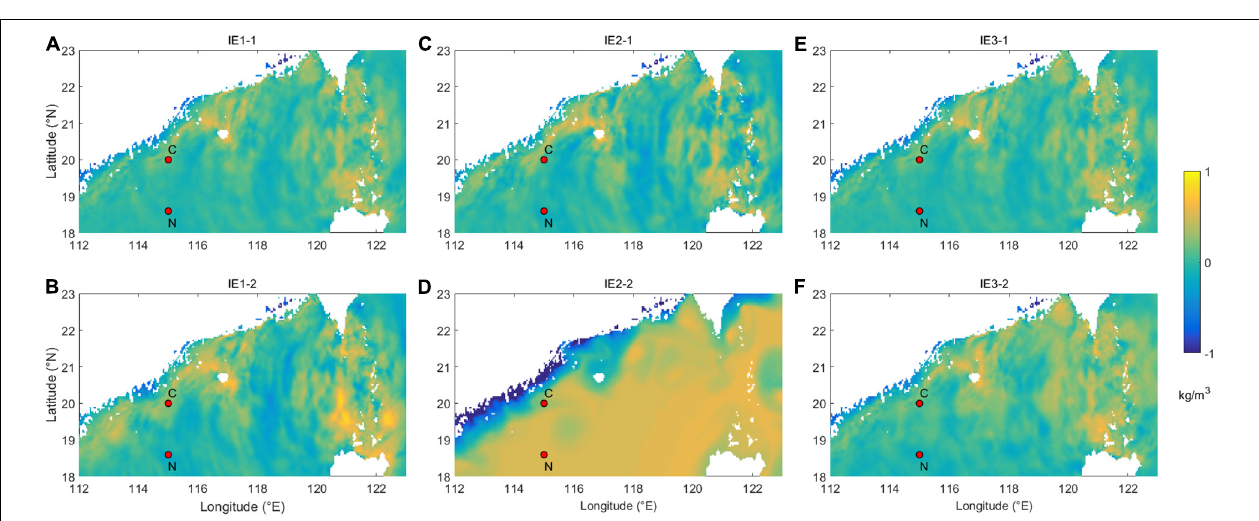
FIGURE 8 | Distributions of density anomaly at the end of simulation duration at 100 m depth for (A,B) IE1, (C,D) IE2, and (E,F)